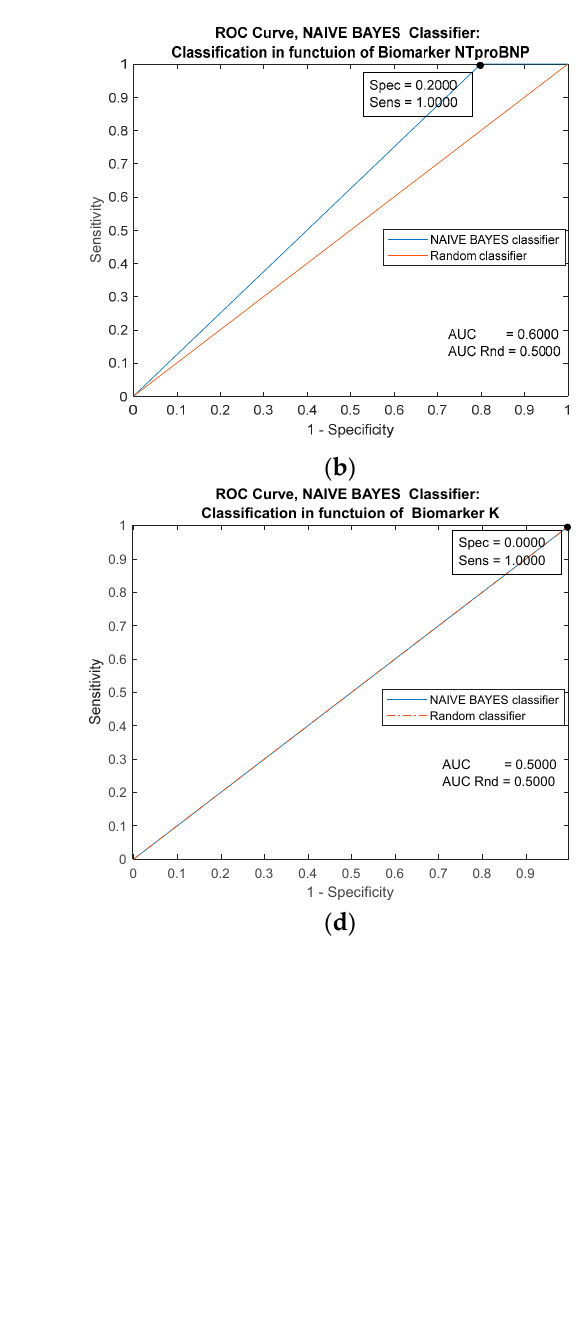
ROC Curve, NAIVE BAYES Classifier: Classification in functuion of Biomarker K